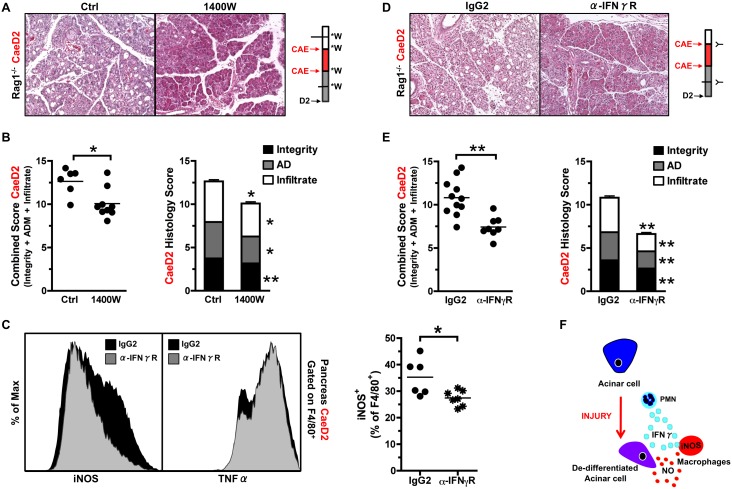
Decreasing inflammatory macrophage activation improves pancreatic injury.(A) H&E staining of pancreas from Rag1−/− mice treated with control or the iNOS inhibitor 1400 W 2-days following caerulein-induced injury. Injection regime of 1400 W (W*) is indicated in adjacent cartoon. (B) Combined and individual pancreatic histology scores from Rag1−/− mice treated with control or iNOS inhibitor 1400 W (n = 6–9). (C) Representative FACS analysis of macrophages expressing iNOS isolated from the pancreas of Rag1−/− mice treated with α-IFNγR and IgG2 isotype control at CaeD2 (n = 4–8). (D) H&E staining of pancreas from Rag1−/− mice treated with α-IFNγR and IgG2 isotype control at CaeD2. Injection regime of α-IFNγR (Y) is indicated in adjacent cartoon. (E) Combined and individual pancreatic histology scores from Rag1−/− mice treated with α-IFNγR and IgG2 isotype control (n = 8–11). (F) Schematic depicting how increased innate inflammation impacts exocrine de-diferentiation.